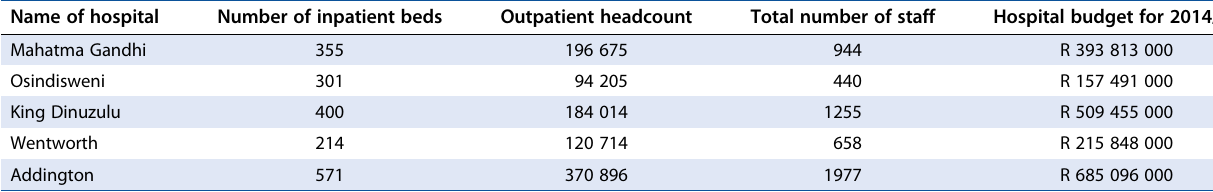
Table 1: Profile of study facilities in eThekwini 2014/2015 Name of hospital Number of inpatient